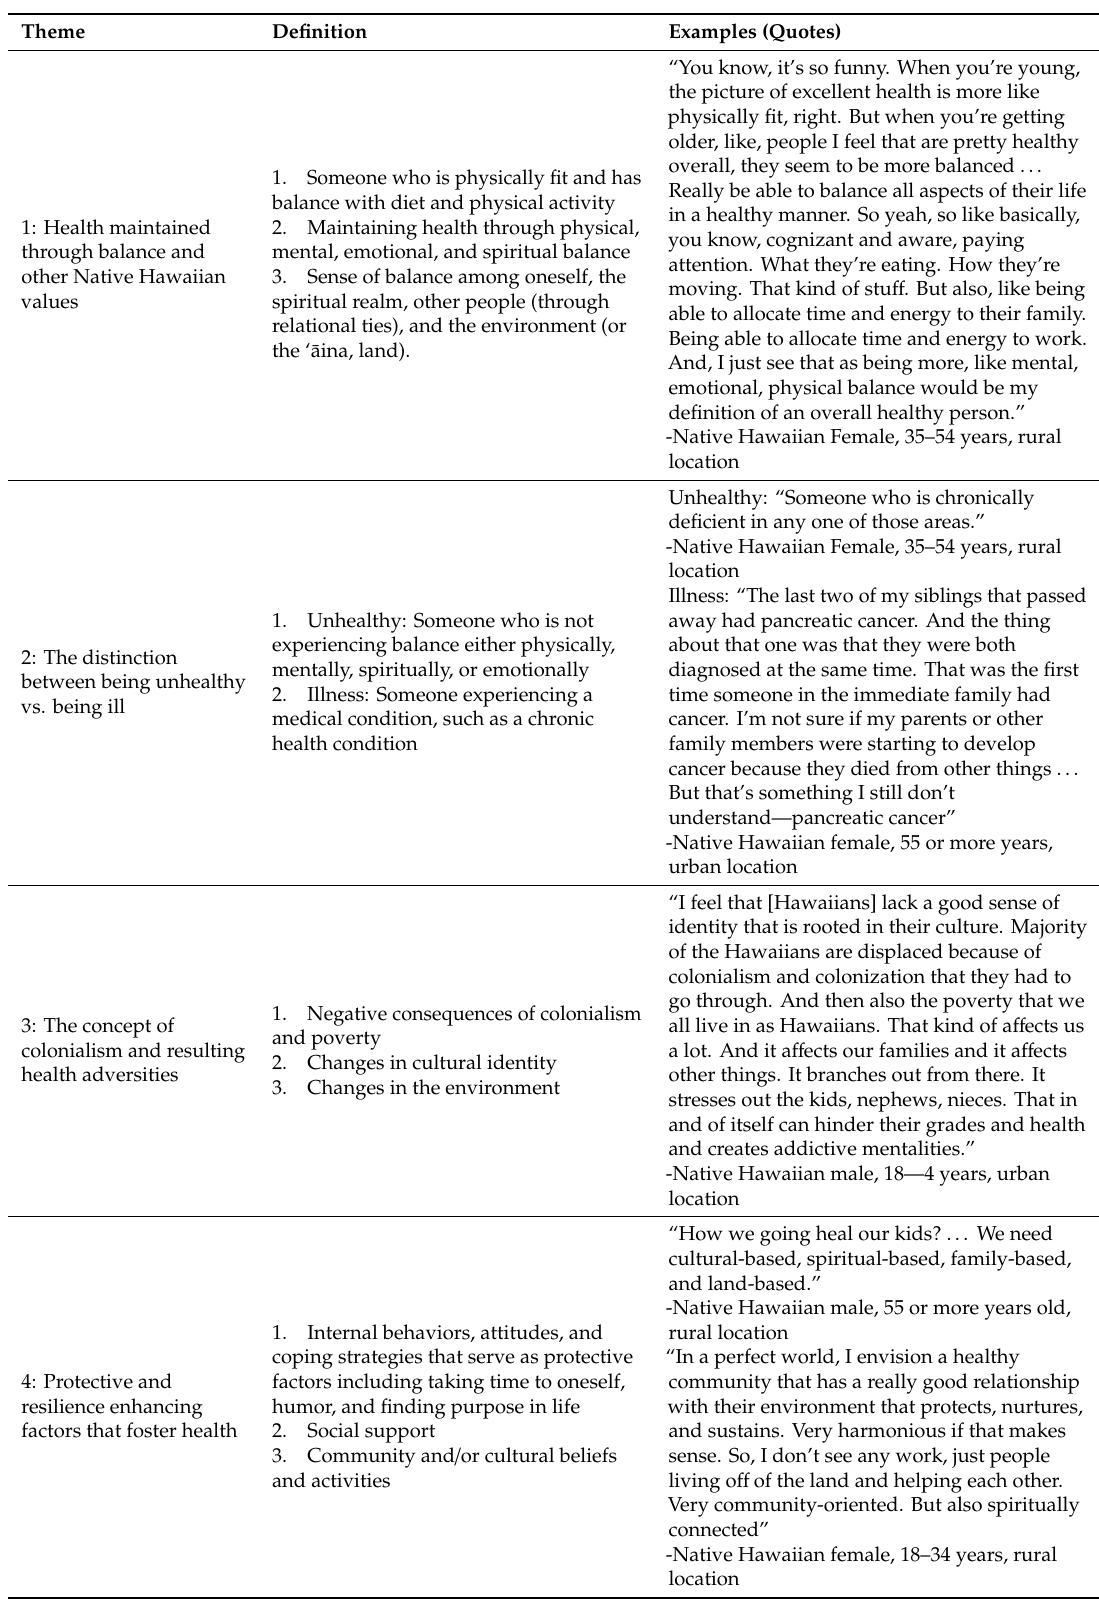
Table 2. Summary of